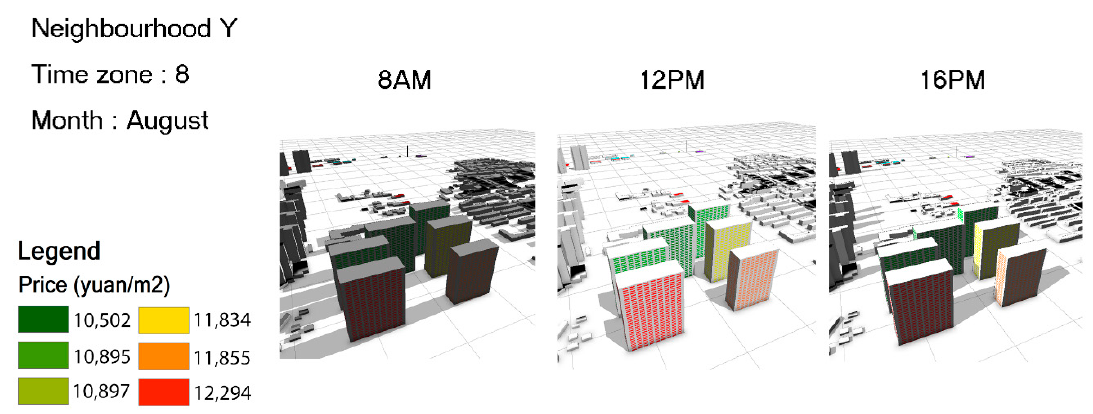
Figure 9. The comparison of sunlight at different times in a day (Y as an example). The colour indicates the property value (green—low and red—high). Land cover is set to invisible for better visualisation.